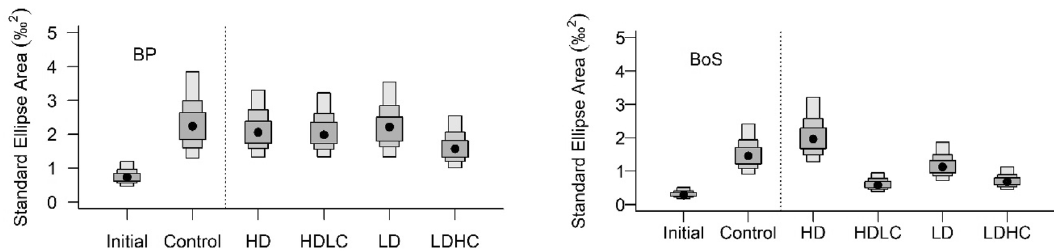
Figure 5. Density box-plot of Bayesian estimates of Standard Ellipse Area (SEAb) for each treatment and population with initial and control amphipods to the left of the dotted vertical line. Black dots indicate the SEAb with 50, 75 and 95% credible intervals produced from 10 5 Bayesian iterations of SEA